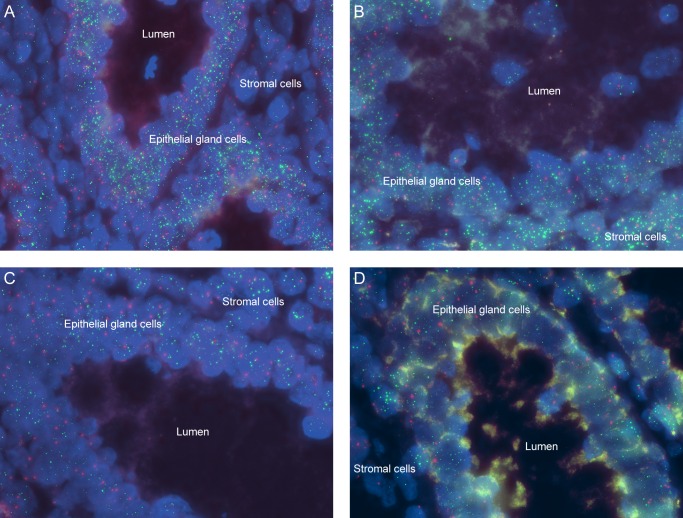
Representative fluorescence images of telomere Q-FISH from various patient age groups.Q-FISH performed with PNA FITC-labelled telomere probe (green) and Cy3-labelled CEN2 probe (red), and nuclei counterstained with DAPI (blue) (original magnification: ×1000). (A) Strong telomere signals (green) are evident in the normal appendix epithelial cells of a 7-week-old infant (age group: 0–20 years). (B) Bright telomere signals are observed in the normal appendix epithelial cells of a 22-year-old individual (age group: 21–40 years), but are slightly reduced in comparison with A. (C) Moderately bright telomere signals in the normal appendix epithelial cells of a 43-year-old individual (age group: 41–60 years), but are reduced compared to younger individuals. (D) Diminished telomere signals in the normal appendix epithelial cells of a 64-year-old individual (age group: > 60 years), compared to those of the younger individuals.